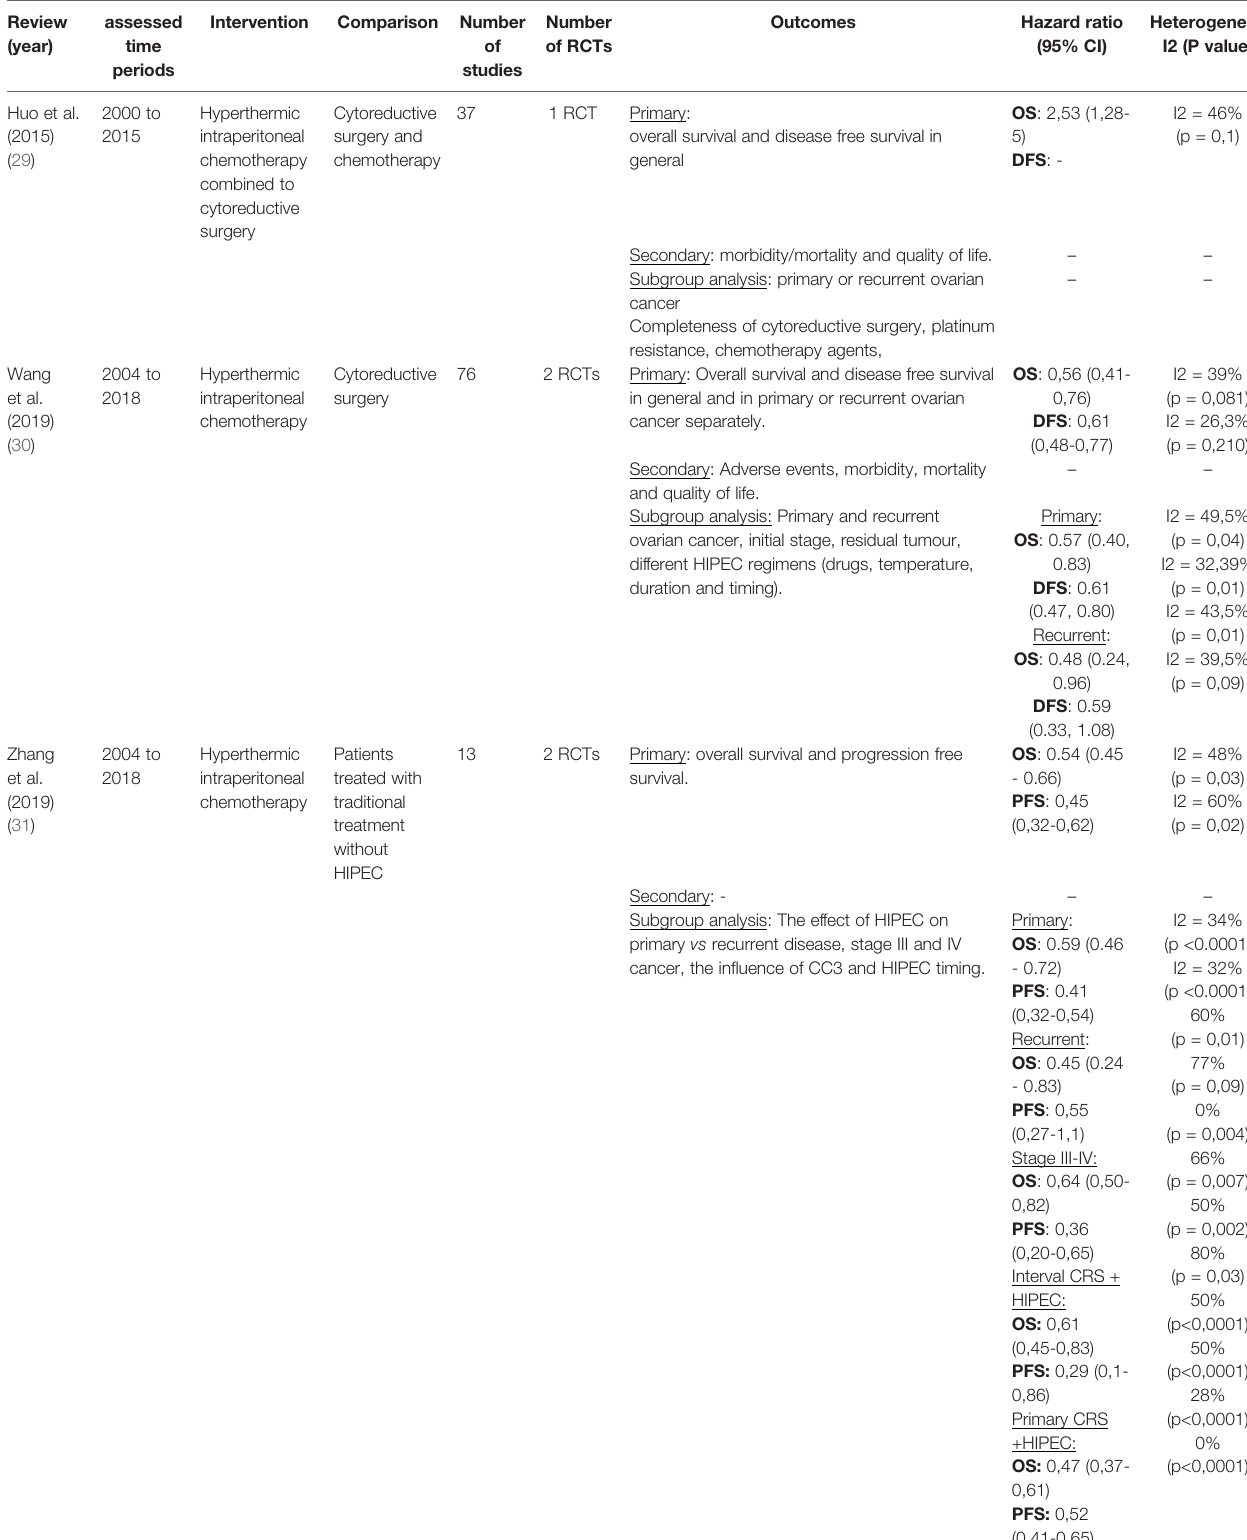
TABLE 1 | Summary of selected